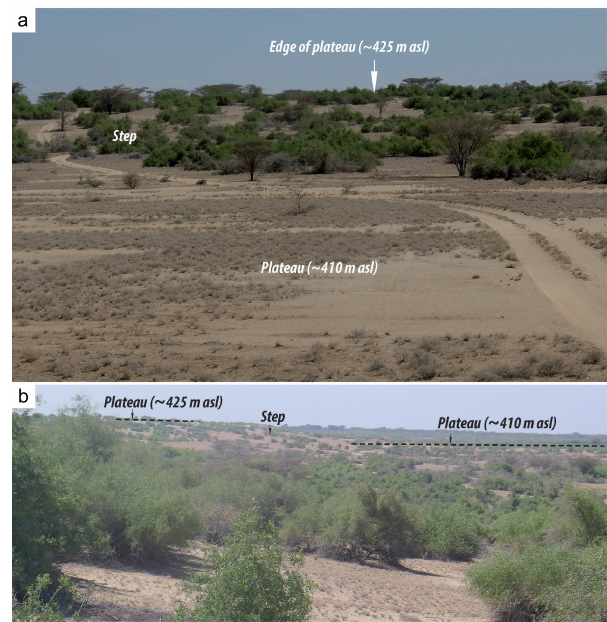
Figure 4. Landforms from the Turkwel delta. (a) Front view of a step grading downward to a plateau. (b) Side view of the same step separating two